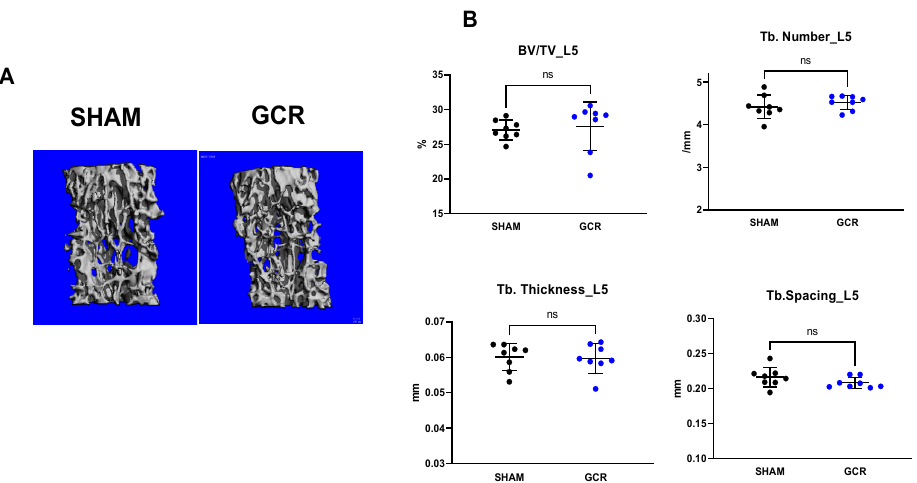
Figure 2. GCR did not alter spinal trabecular bone in male mice. ( A ) Representative images of lumbar vertebra (L5) of sham and 0.5 Gy GCR exposed adult male BalbC mice 3 months following exposure. ( B ) No significant changes were detected in trabecular parameters (BV/TV; Tb. number, Tb. spacing, Tb. Thickness) in L5 vertebra (n = eight mice per group). Data are presented as ± SD. p values were determined using Student’s t -test. (n = 8, n.s.: not significant).